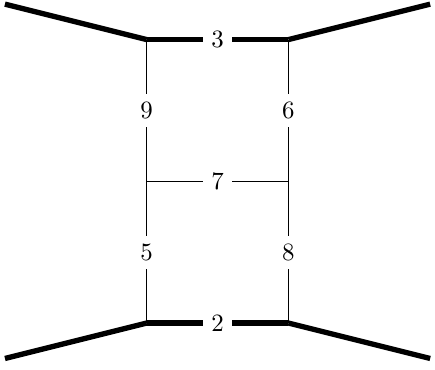
Figure 13. H topology. Indices correspond to the propagators listed in eq.